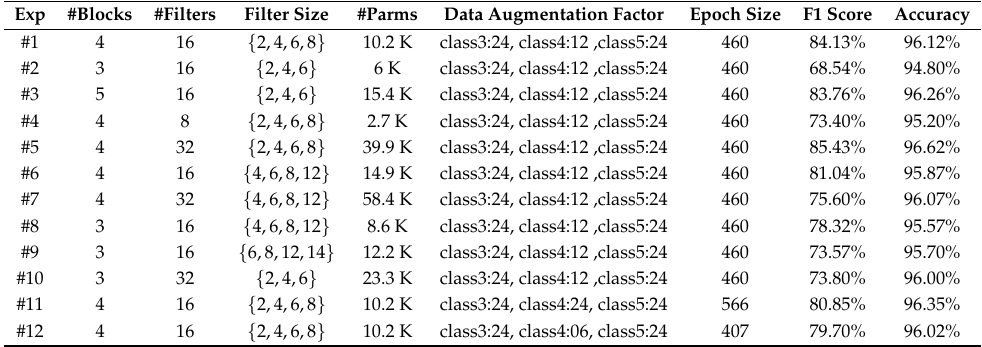
Table 1. Different forms of the TCN model proposed in Section 3.1 with different data augmentation cases. # Epochs = 250 and Mini - Batch Size = 20.